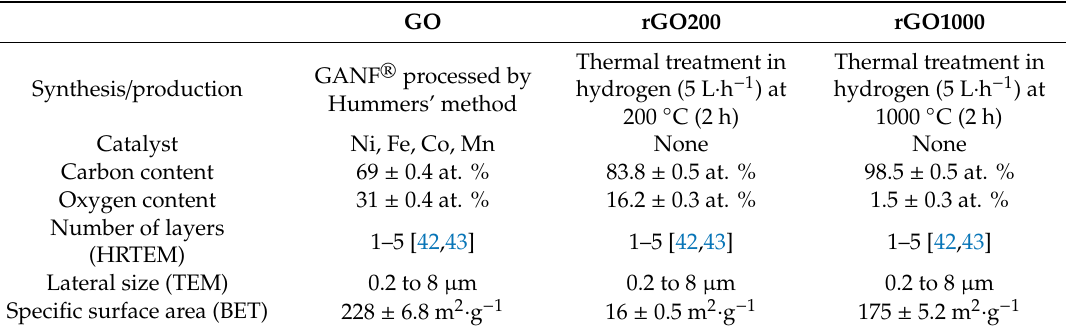
Figure 1. Transmission electron microscopy micrographs of ( A ) Graphene oxide, ( B ) reduced graphene oxide at 200 °C, ( C ) reduced graphene oxide at 1000 °C. Table 1. Physico-chemical characteristics of graphene oxide (GO); reduced graphene oxide (rGO)200 and rGO1000. TEM: transmission electron microscope; HRTEM: high resolution TEM; BET: Brunauer-Emett-Teller; at. %: atomic %; GANF ® : Grupo Antolin carbon nanofibers.